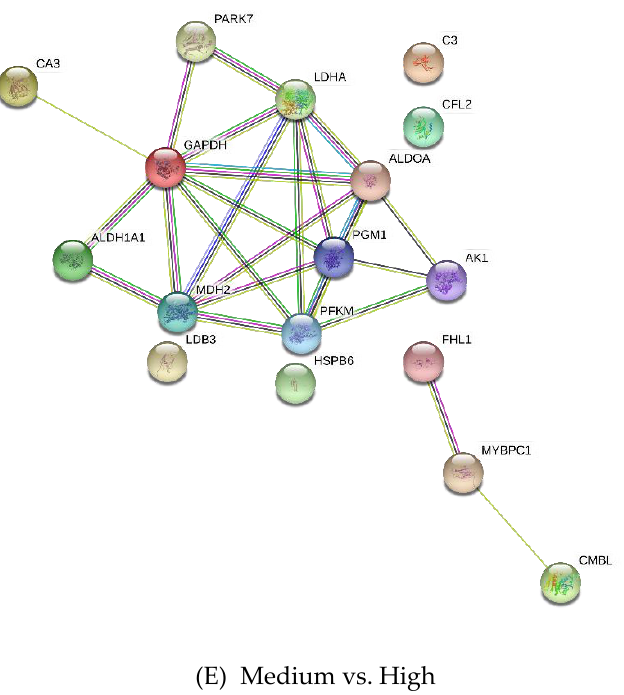
Figure 6. The protein–protein interaction network of differentially expressed proteins in the comparisons: Control vs. Low ( A ), Control vs. Medium ( B ), Control vs. High ( C ), Low vs. High ( D ) and Medium vs. High ( E ). Colored ball: the changed protein; yellow line: text mining; purple line: experiments; blue line: databases; light blue: homology; black line: co-expression; green line: neighborhood; red line, gene fusion; deep blue line: cooccurrence.